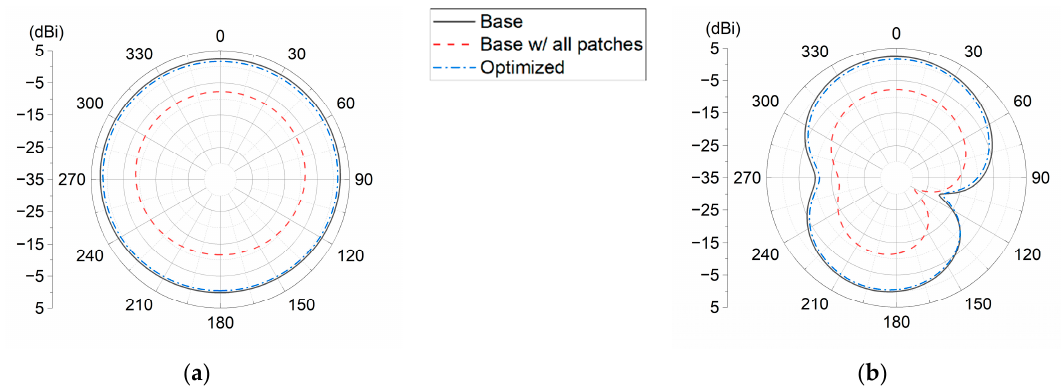
Figure 5. Simulated radiation pattern of the base, base with all patches, and optimized IFAs with 14 mm ground clearance. ( a ) φ = 90 ° and ( b ) φ = 0 ° plane. Unit in degrees along θ .